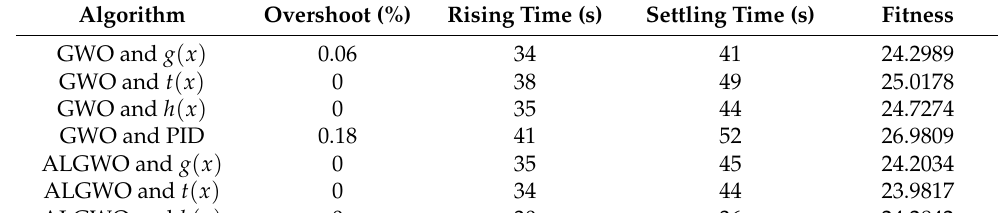
Table 9. Performance characteristics on test system 5.